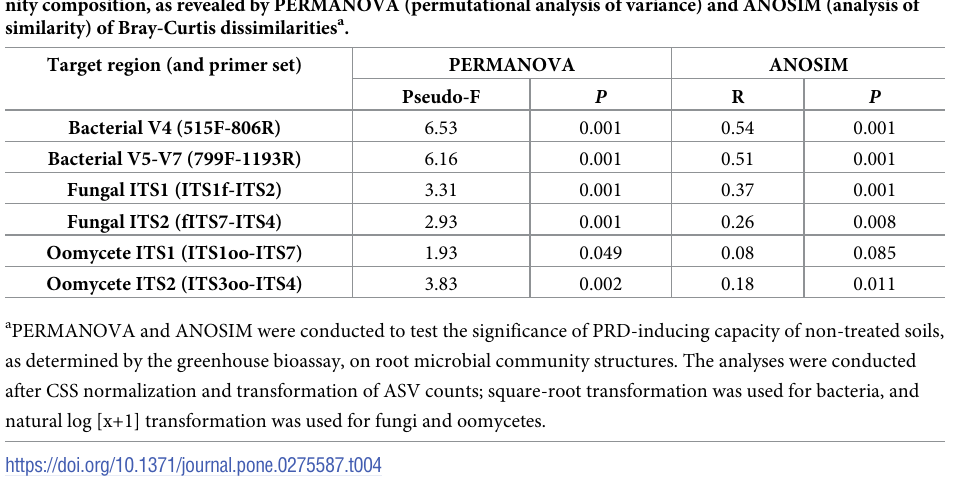
Oomycete community diversity indices did not differ significantly between root samples from PRD-inducing and non-inducing soils for either ITS1 or ITS2 amplicons ( P = 0.08 to 0.65; Table 3). Among ITS1 amplicons, PERMANOVA and ANOSIM of BC-dissimilarities revealed a relatively small impact of the PRD-inducing capacity of the soils on oomycete communities in the roots (PERMANOVA pseudo-F = 1.93, P = 0.049; ANOSIM R = 0.084, P = 0.083) (Table 4 and S1E Fig). However, among the ITS2 amplicons, there was a stronger effect of PRD-inducing capacity on oomycete root communities (PERMANOVA pseudo-F = 3.83, P = 0.002; ANOSIM R = 0.177, P = 0.011) (Table 4 and S1F Fig). At genus level, Pythium and Phytopythium dominated the root-associated oomycete communities, both in PRD-inducing and non-inducing soils (Fig 5C and 5D).